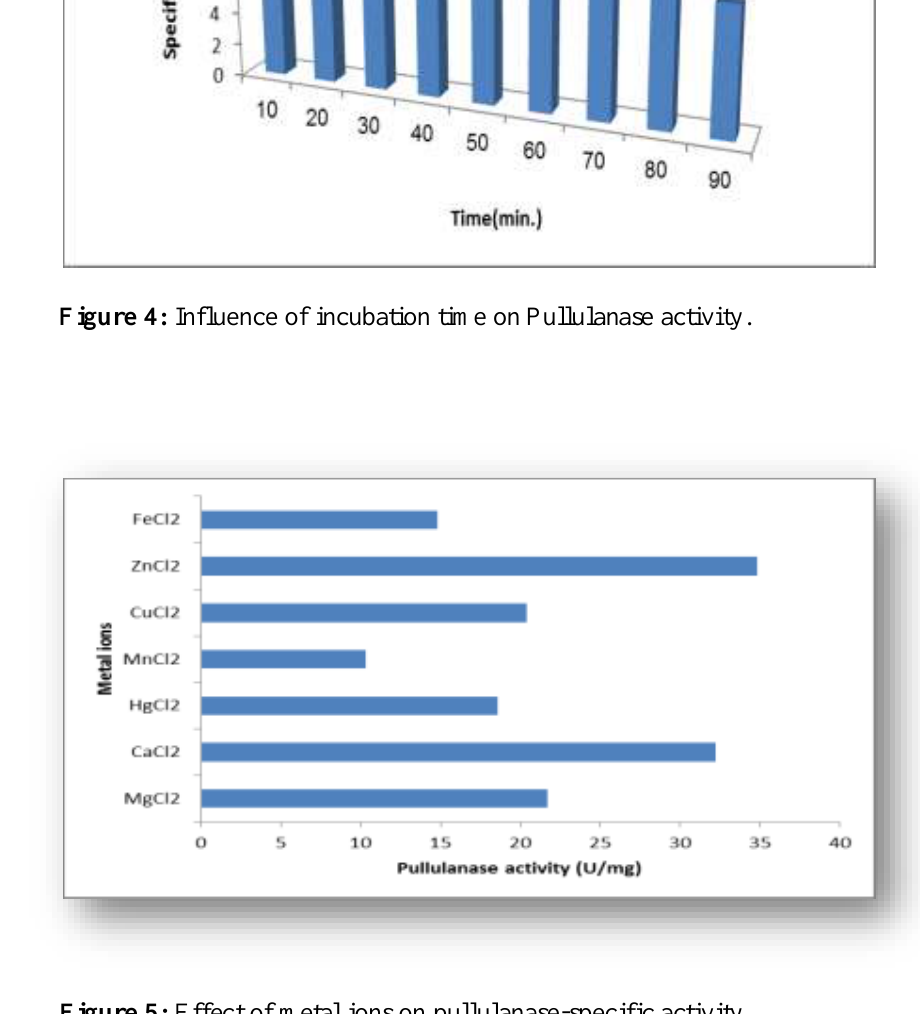
Figure 5: Effect of metal ions on pullulanase-specific